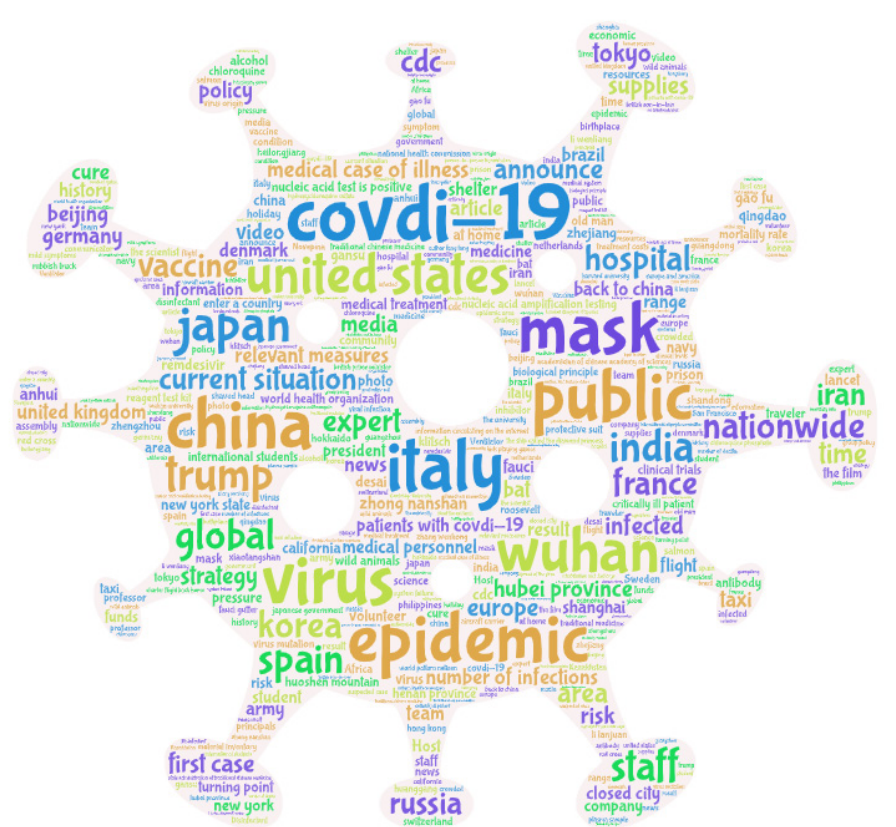
Figure 1. Word-cloud diagram of essential posts in the COVID-19 topic community.